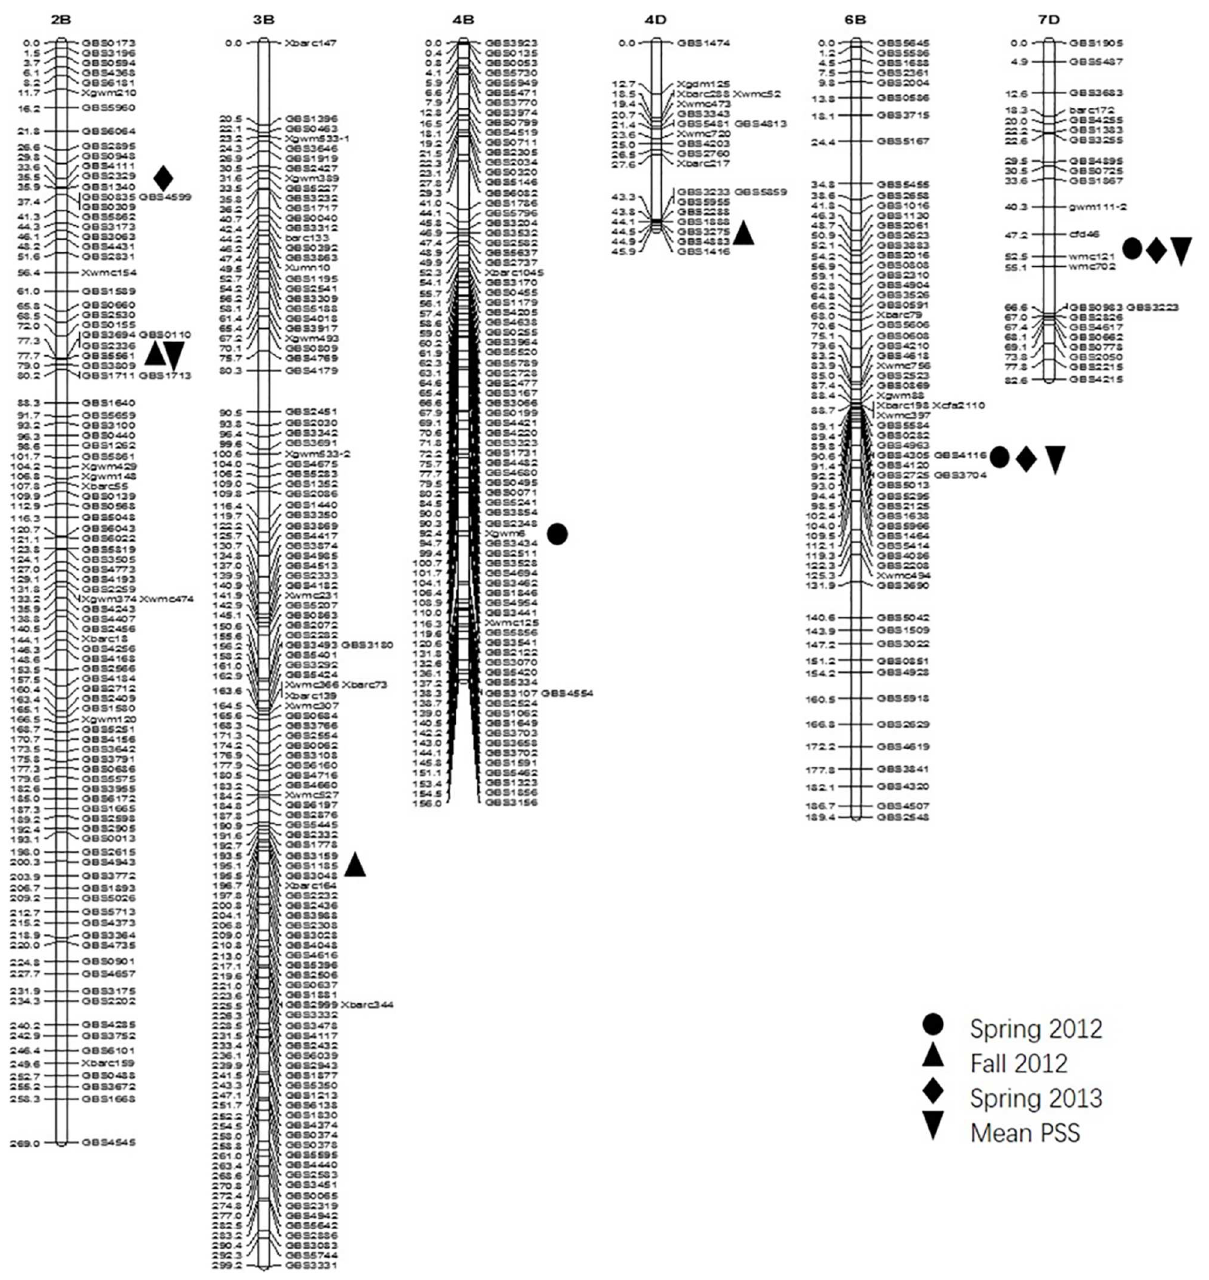
Fig 3. Maps of QTLs on 2B, 3B, 4B, 4D, 6B, and 7D for FHB type II resistanceconstructed from the RIL population derived from the cross ‘HYZ’ x